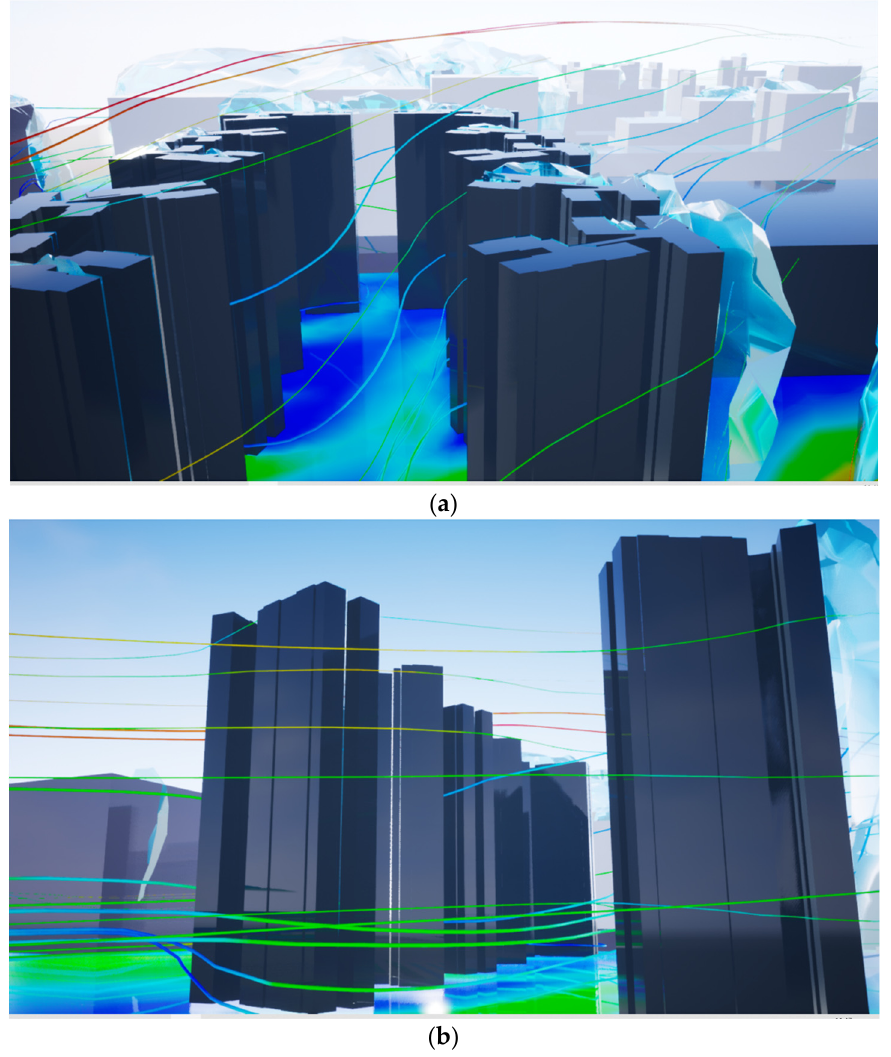
Figure 18. The wind velocity gradually decreases as it passes through the modular buildings. ( a ) Aerial view, ( b ) Ground view. (Wind speed: yellow—moderately high, green—moderately low, light blue—low, dark blue—weak).